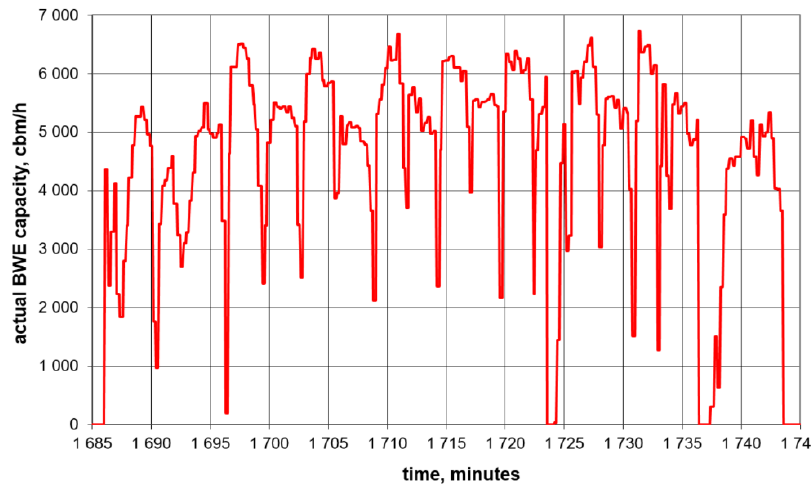
Figure 2. Actual volume capacity for the SRs 2000 bucket-wheel excavator recorded in the Belchatow surface lignite mine during the excavation of one terrace [20].